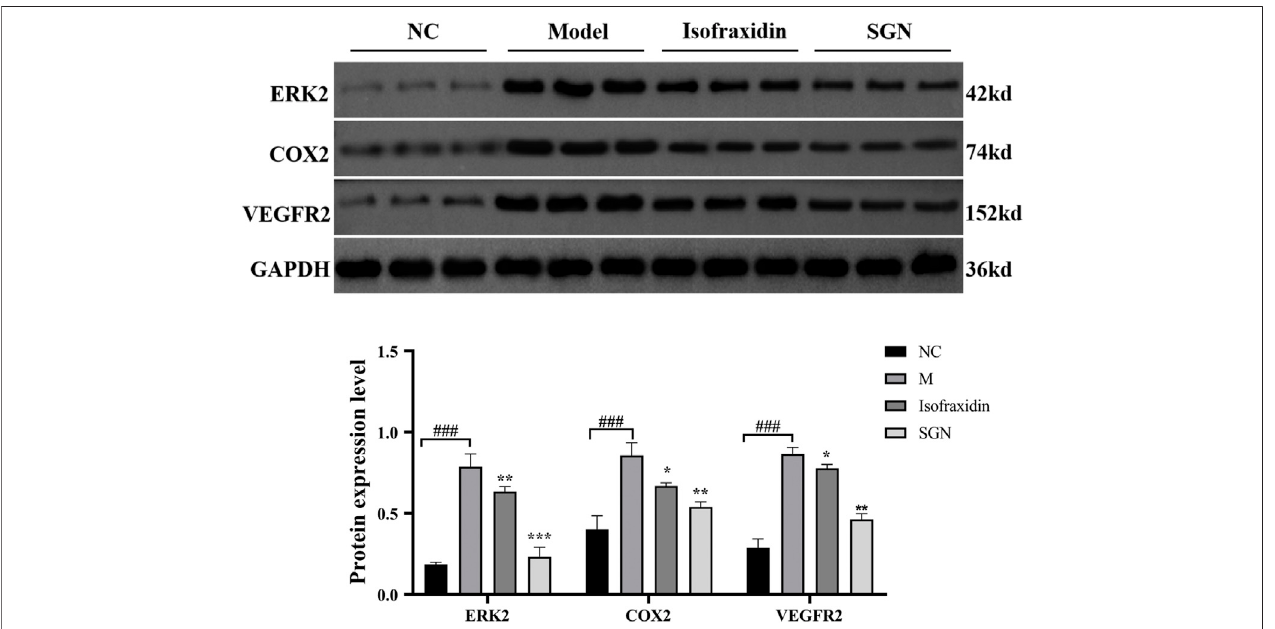
FIGURE11| Theexpressionofrelatedproteinsineachgroupofrats.Thedatapresentedaremeans±SD( n =3).### p < 0.01relativetotheNCgroup.Compared with the M group, * p < 0.05, ** p < 0.01 and *** p < 0.01.